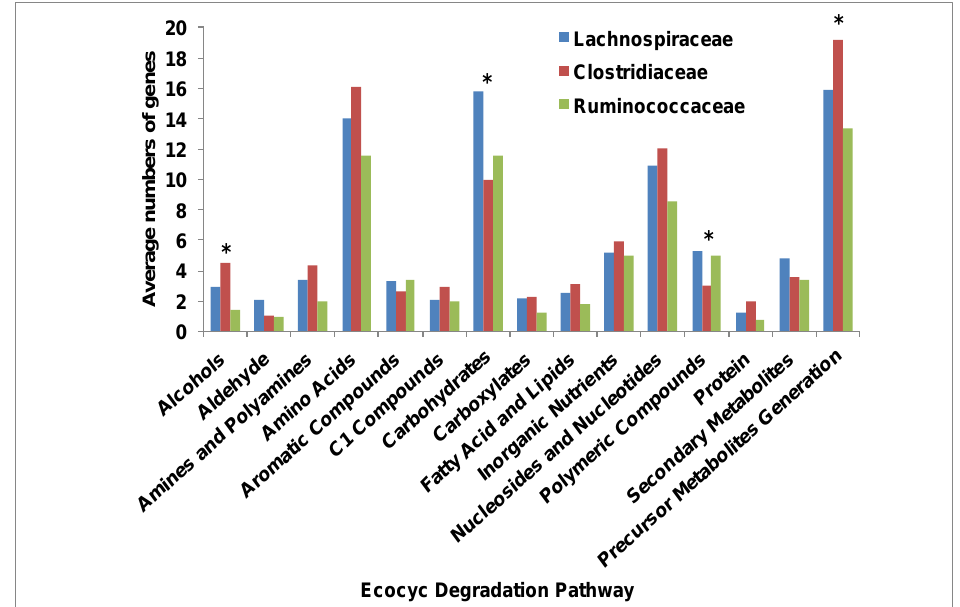
Figure 9. A comparison of average abundance of genes in each Ecocyc degradation [35] pathway for Lachnospiraceae, Clostridiaceae, and Ruminococcaceae genomes. (*) Pathways showing significant differences between groups in either one-way ANOVA testing (for normal data) ( p -value < 0.05) or the best fit between negative binomial or Poisson regression models as determined by the likelihood ratio test ( p -value <